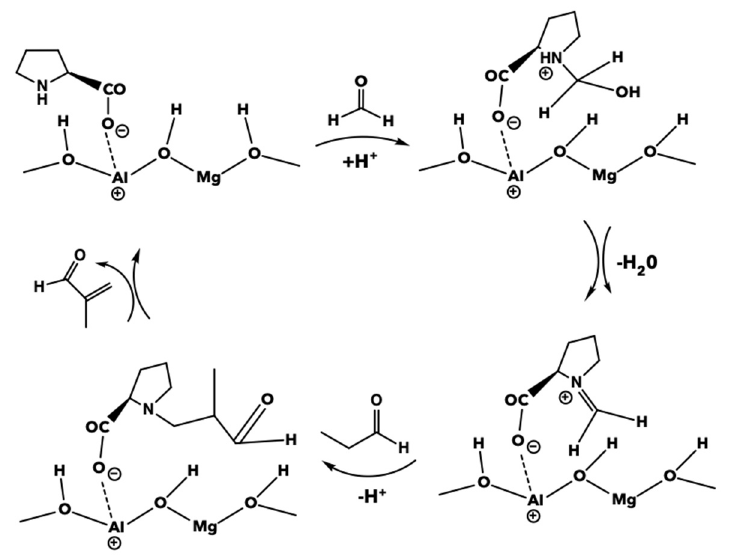
Figure 7. Proposed catalytic cycle for the aldol condensation reaction with the Mannich pathway.